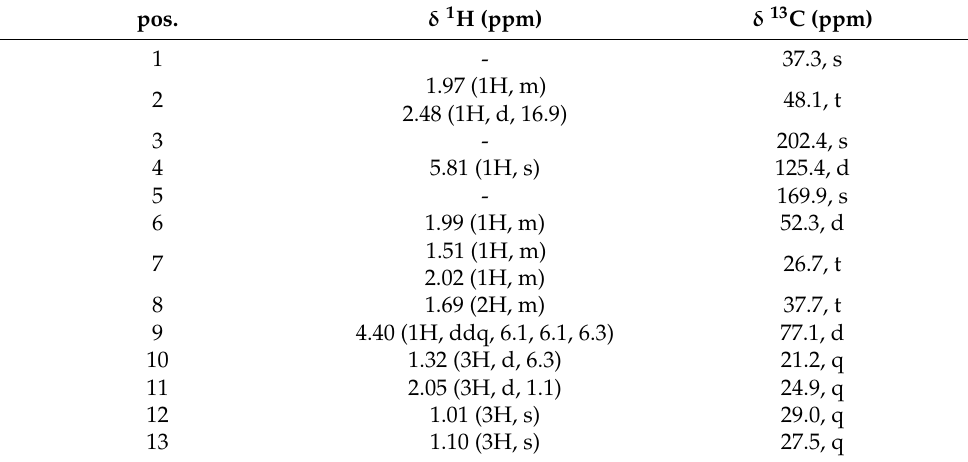
of carbon atoms is in accordance to Figure 4.